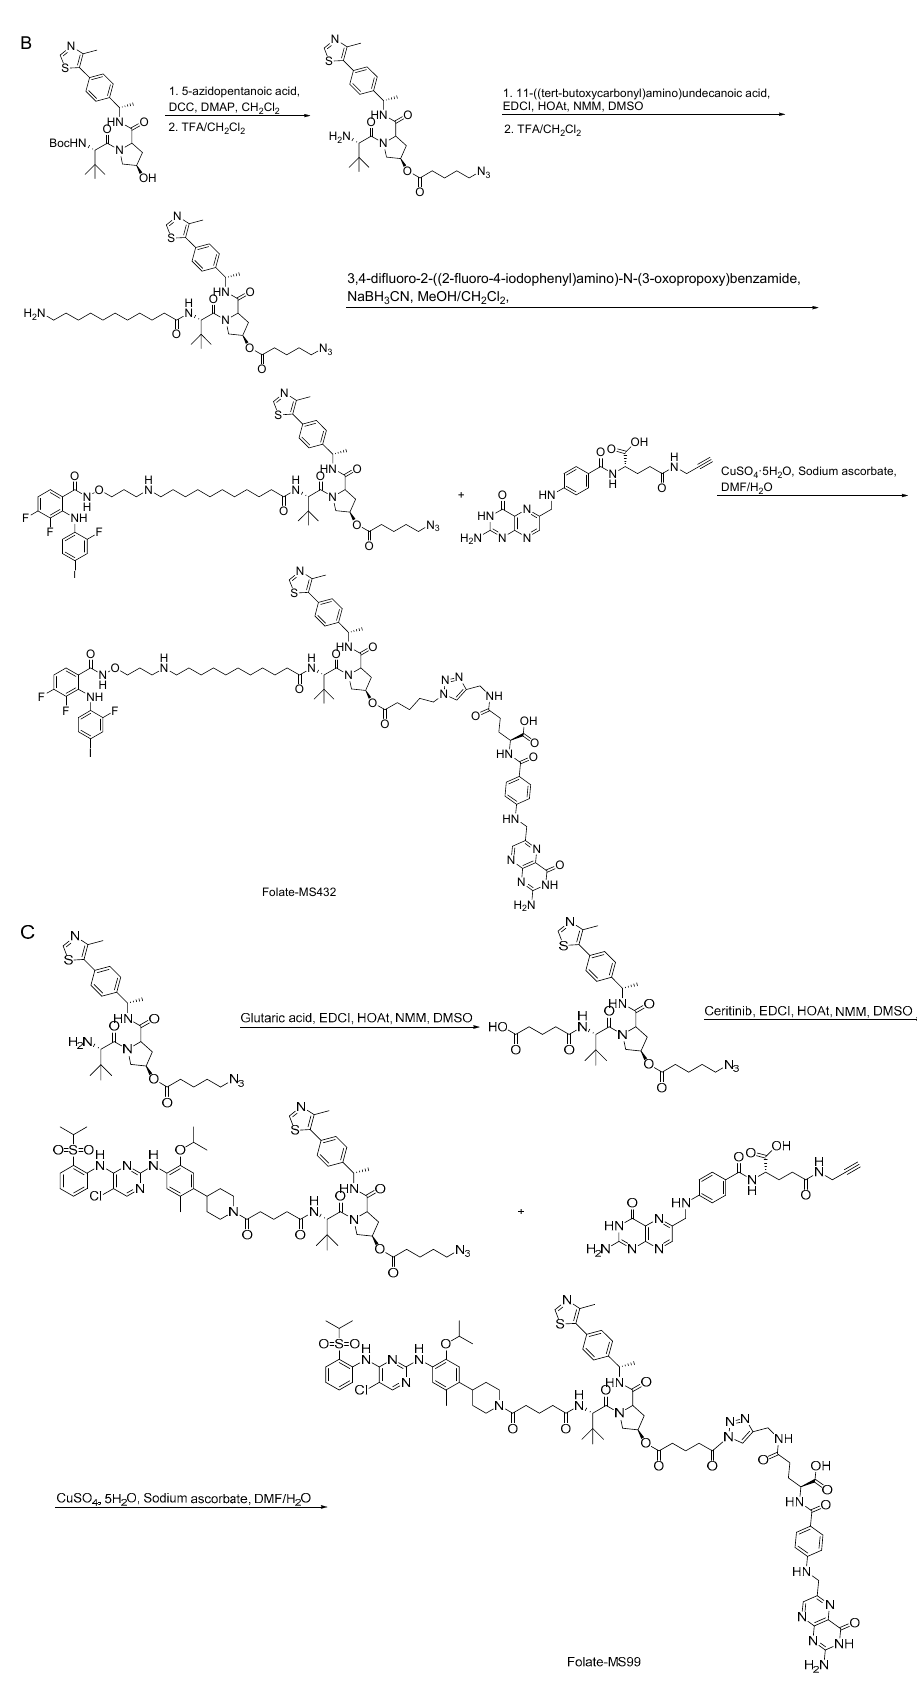
Scheme 14. Synthesis of folate–based PROTACs. ( A ) Synthesis of folate-ARV-771. ( B ) Synthesis of folate-MS432. ( C ) Synthesis of